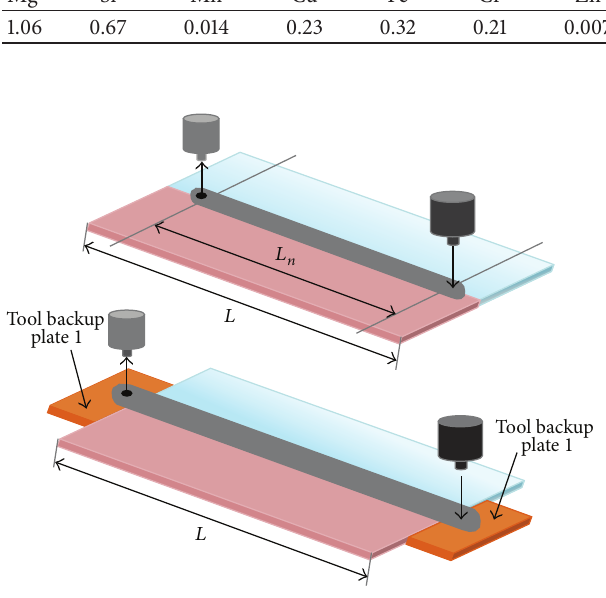
Figure 1: Schematic diagram of the FSW process.